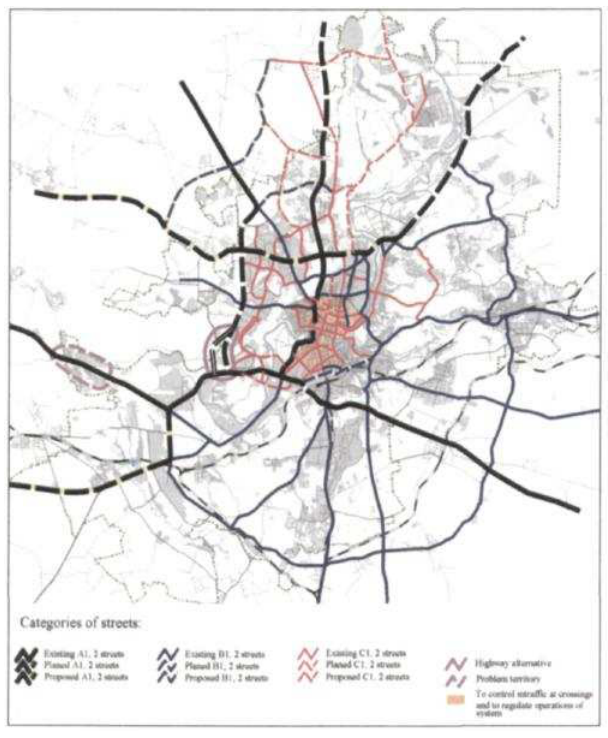
Fig 4. Proposed street